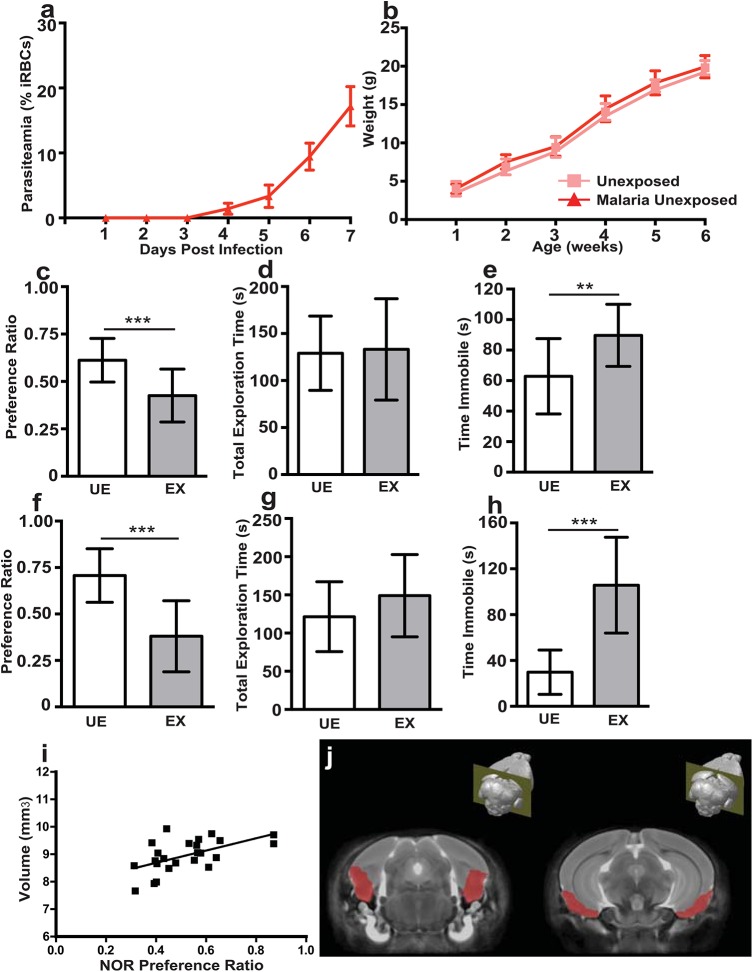

In utero exposure to EMIP induces a persistent neurocognitive phenotype in offspring but is not associated with regional volumetric anatomical changes determined by MRI.
(a) Maternal parasitaemia (day one to seven post infection, n = 5) expressed as percent of infected red blood cells (iRBCs) per total red blood cells counted. (b) Offspring weight from one to six weeks of age in unexposed (n = 15) and malaria exposed offspring (n = 13). (c) Testing performance (preference ratio) and (d) total exploration time of unexposed (UE, n = 15) and malaria exposed (EX, n = 13) offspring (6 weeks of age) in the NOR test. (e) Performance of UE (n = 15) and EX (n = 15) offspring (6 weeks of age) in the TST test. (f) Testing performance (preference ratio) and (g) total exploration time of unexposed (UE, n = 11) and malaria exposed (EX, n = 12) offspring tested at 20 weeks of age in the NOR test. (h) Performance of UE (n = 11) and EX (n = 12) offspring in the TST test at 20 weeks of age. (i) Correlation between entorhinal cortical volume and performance (preference ratio) in the NOR test of unexposed and malaria exposed offspring (n = 24, spearman rho = 0.4912, P = 0.0044). (j) Depiction of average MRI, generated from all scans and all experimental groups, and outline of area used to define the entorhinal cortex. **P < 0.01, ***P < 0.005; T-Test. Data are presented as mean +/- SD.